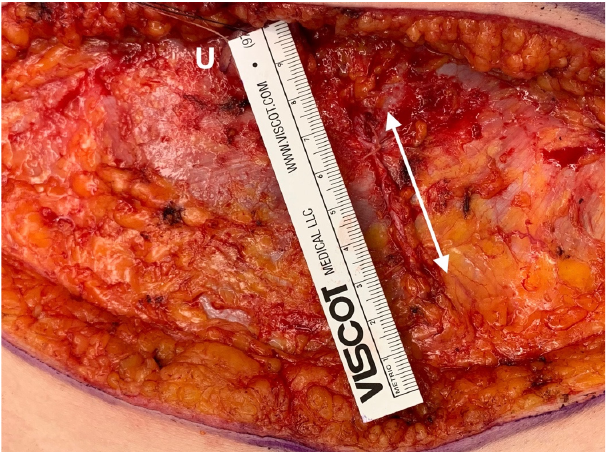
Figure 1. Intraoperative view of DIEP-flap donor site (ERAS-group). Rectus abdominis sheath incision sutured, marked with white double arrow, approximately 5 cm length. Umbilicus (marked with U) hidden behind the upper part of ruler.